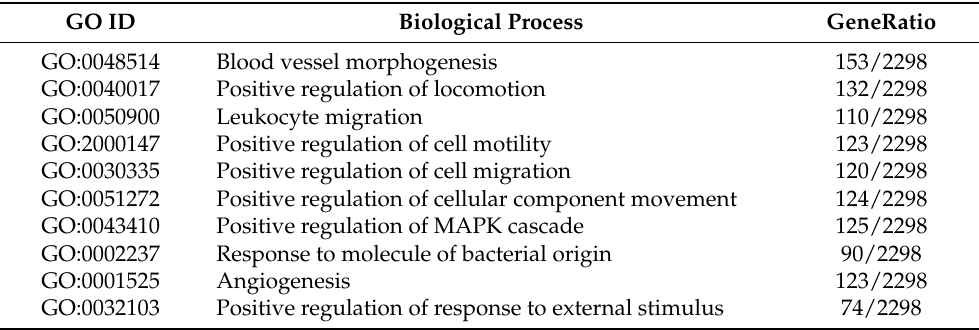
Table 9. Top 10 biological processes significantly (padj ≤ 0.01) enriched in genes differentially expressed in M2_B versus M2_A macrophages.